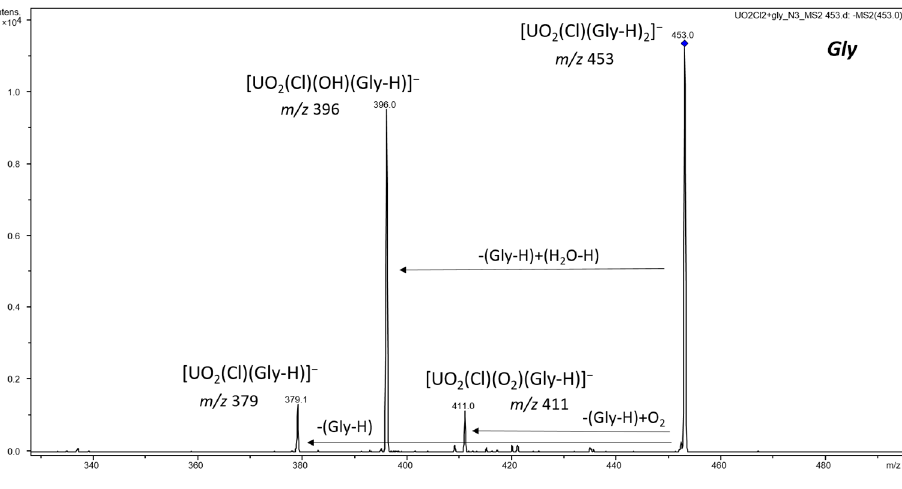
Figure 6. CID mass spectrum of [UO 2 (Cl)(Gly-H) 2 ] −